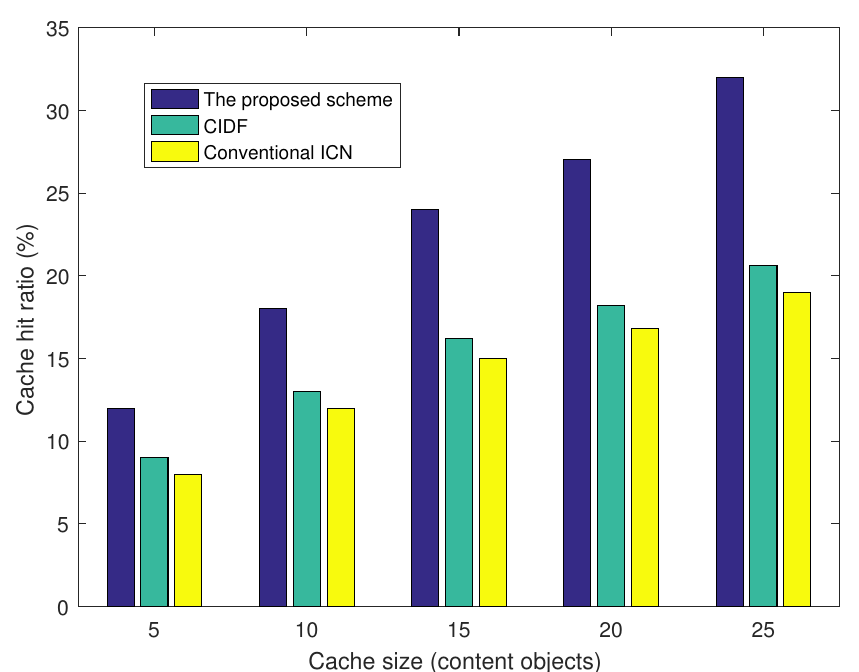
Figure 4. Average cache hit ratio vs. cache size.